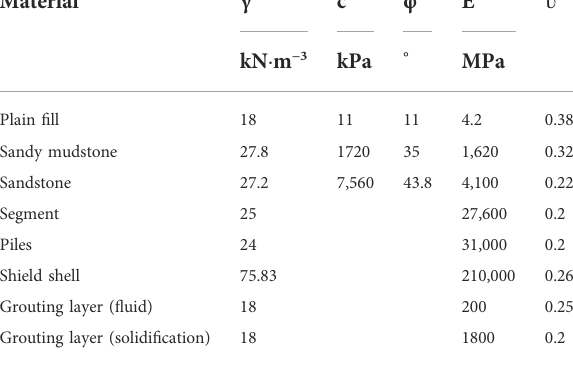
TABLE 1 Parameters of strata and materials.